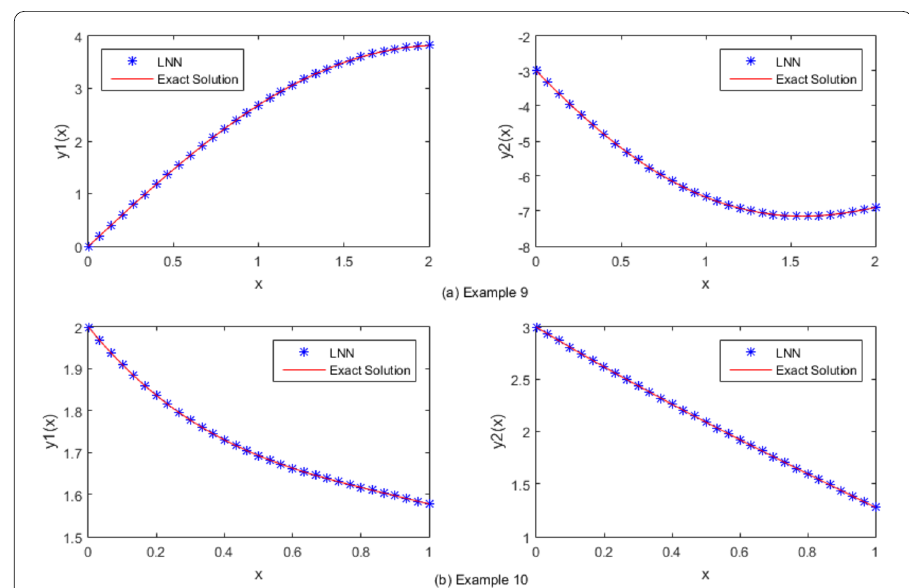
Figure 6 Comparison between exact and LNN results for